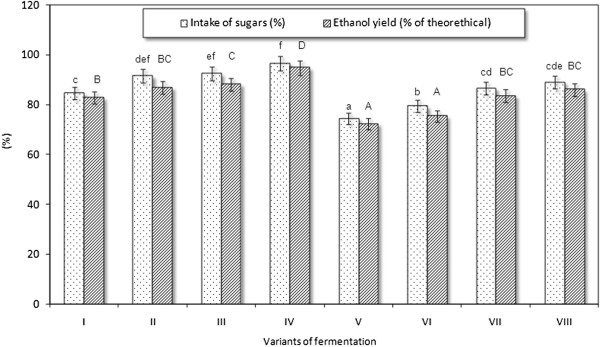
Fermentation results of thick juice worts. Different letters indicate significant differences (P <0.05) between the means of intake of sugars (lowercase letters) and ethanol yield (capital letters). Variants of fermentation: I, extract content of 250 g/kg, inoculum content of 1.0 g/L; (NH4)2HPO4. II, extract content of 250 g/kg, inoculum content of 1.0 g/L; (NH4)2HPO4 + MgSO4 · 7 H2O. III, extract content of 250 g/kg, inoculum content of 1.5 g/L; (NH4)2HPO4. IV, extract content of 250 g/kg; inoculum content of 2.0 g/L; (NH4)2HPO4. V, extract content of 280 g/kg, inoculum content of 1.0 g/L; (NH4)2HPO4. VI, extract content of 280 g/kg, inoculum content of 1.0 g/L; (NH4)2HPO4 + MgSO4 · 7 H2O. VII, extract content of 280 g/kg, inoculum content of 1.5 g/L; (NH4)2HPO4. VIII, extract content of 280 g/kg, inoculum content of 2.0 g/L; (NH4)2HPO4.